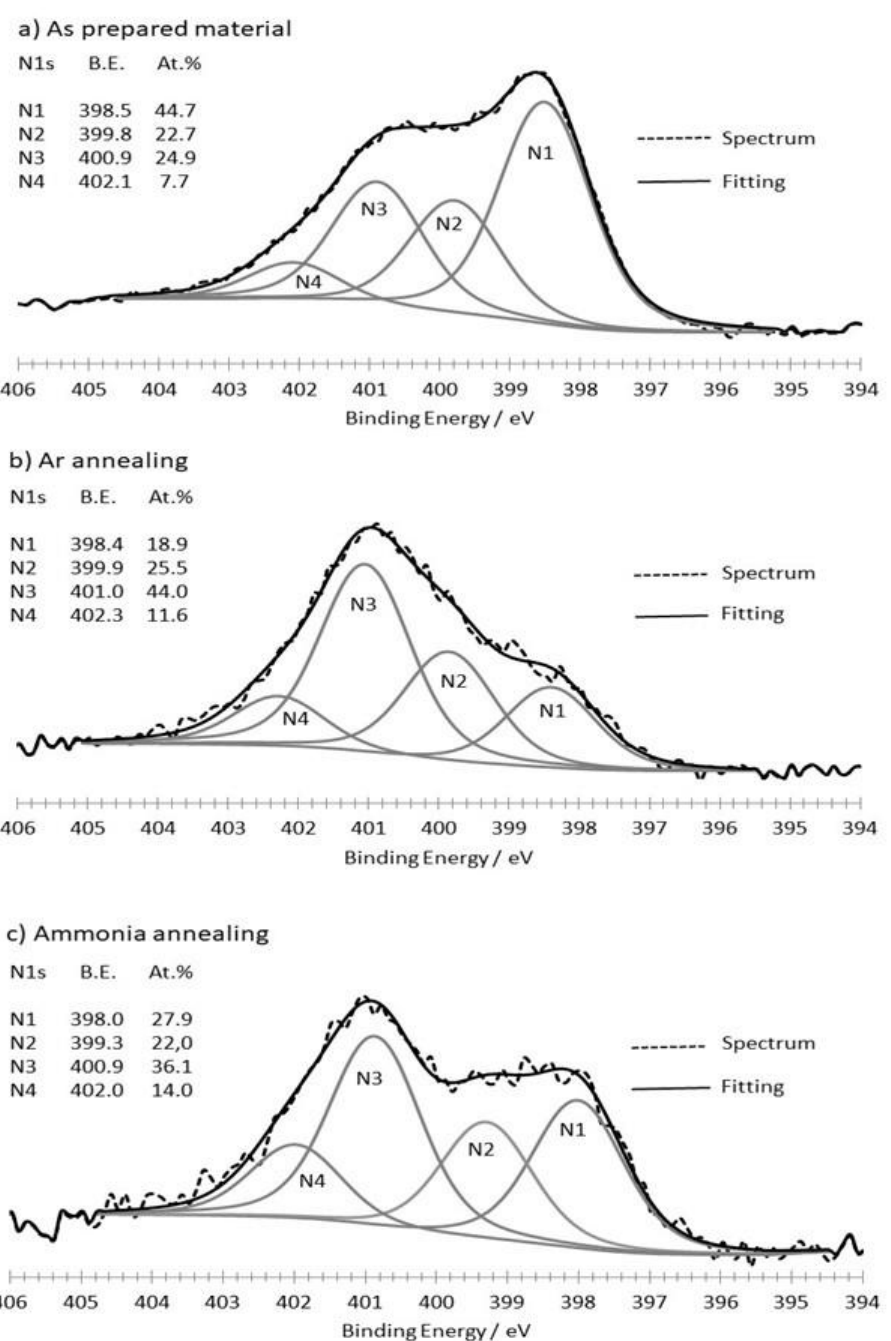
Figure 4. N1s XPS peak fitting of the as-formed and annealed materials. ( a ) As-formed material; ( b ) Argon annealed material; ( c ) Ammonia annealed material.